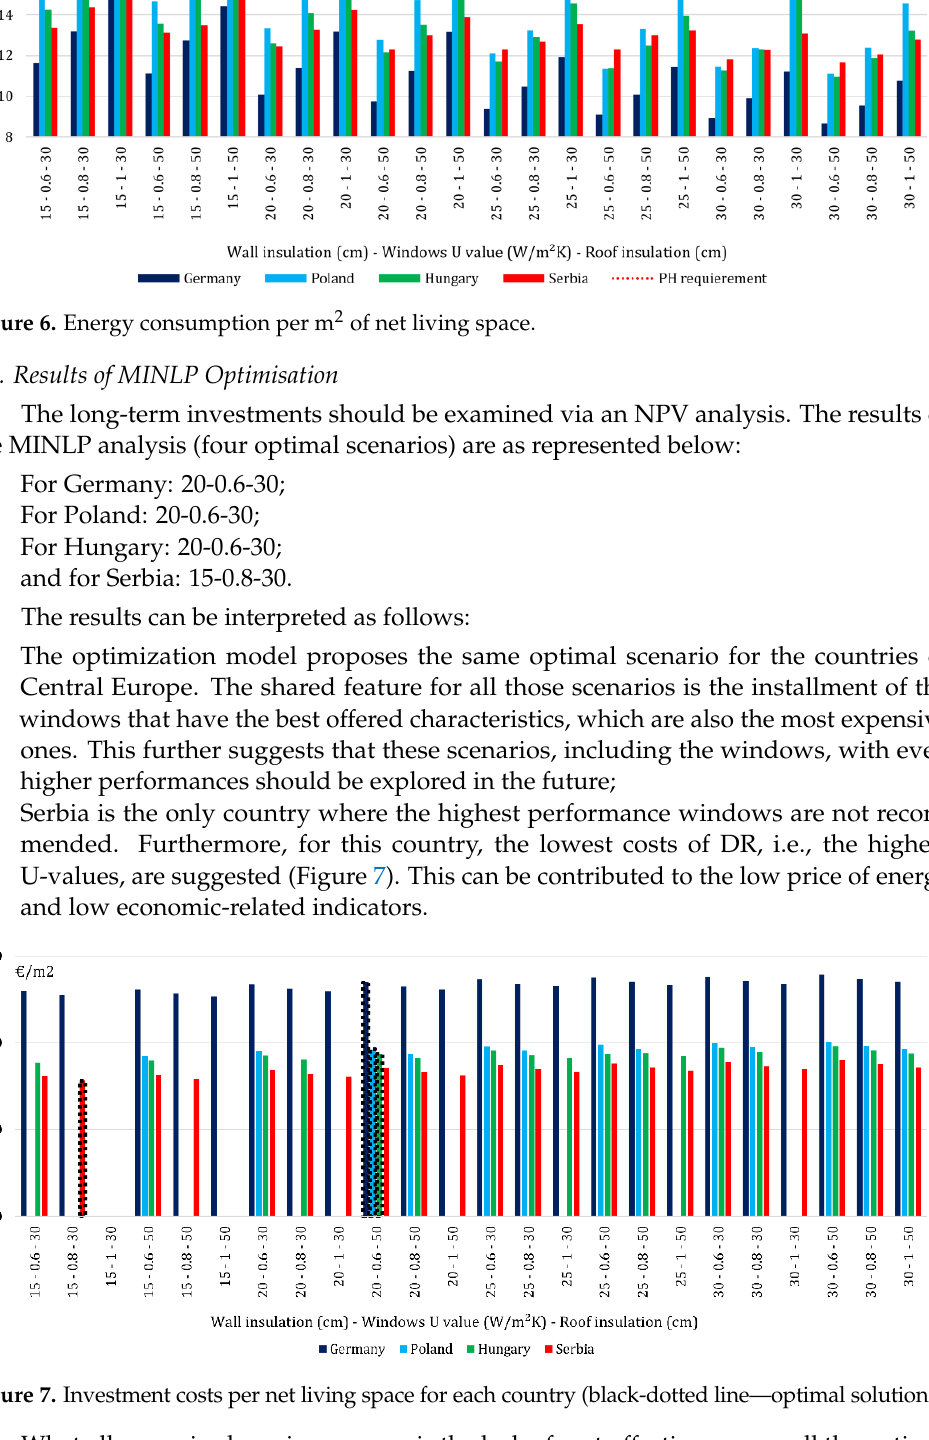
Figure 8. Results of NPV analysis for optimal scenarios without incentives (d = 3.5%, energy price rise 2% per year). In the following section, two ways to encourage the DR cost-effectiveness are ex- plored: carbon tax and upfront subsidies. The carbon tax was or should be introduced as a method for reducing the emissions of CO 2 and other greenhouse gases. CO 2 taxation is also likely to have long-term effects, especially if the rate reaches higher levels; therefore, this can be expected to lead to more renovations in the future [40]. The tCO 2 saved per the PH compliant buildings ’ lifetime (50 years) per 1000 € in- vested is shown in Figure 9. The data presented here are used to propose an adequate carbon tax for each optimal scenario.